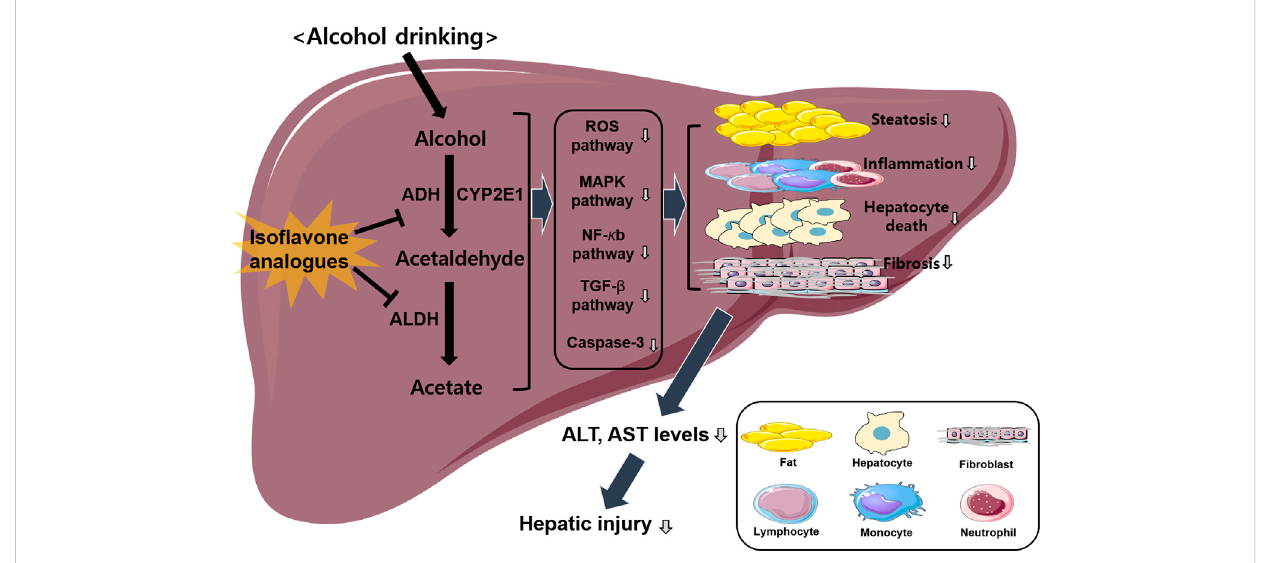
FIGURE 1 Overview of iso fl avone analogues-induced protective effects against ALD. Alcohol drinking induces hepatic injury via activating several different pathways including ROS, MAPK, NF- κ b, and TGF- β signaling. Iso fl avone analogues have protective effects against ALD induced by various factors including in fl ammation, steatosis, fi brosis, and apoptosis. Finally, this pathway decreases hepatic injury via the inhibition of alcohol